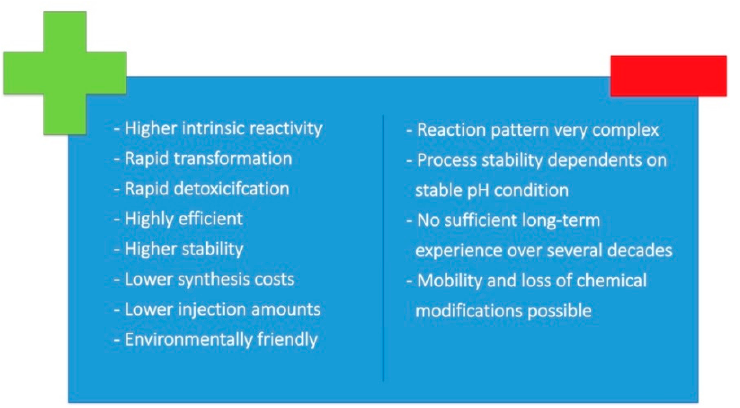
Figure 5. Summary of the advantages and disadvantages of applying NPs for environmental